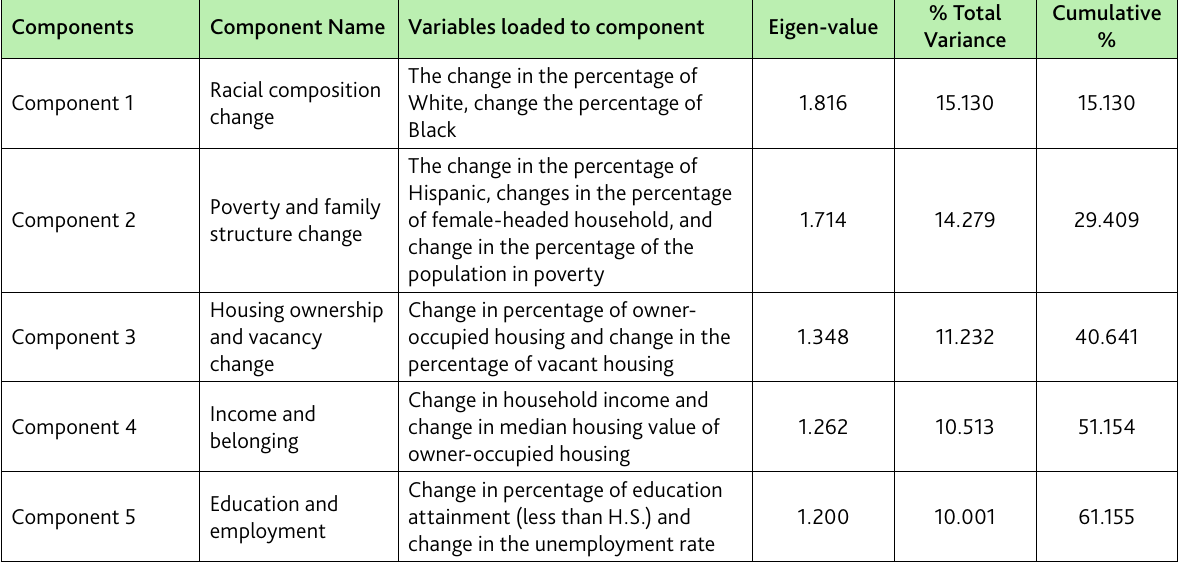
Table 1. The components and their explanatory power